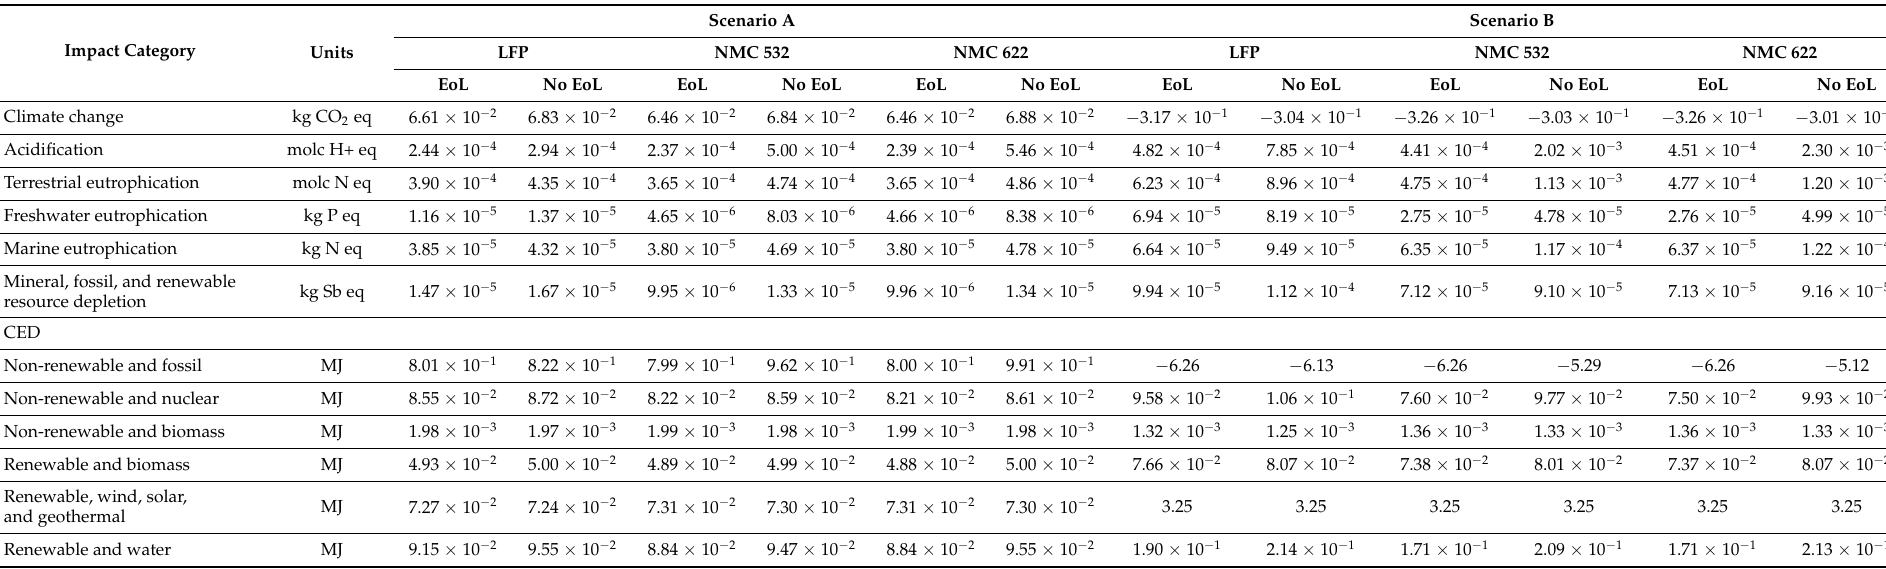
Table 9. Life cycle environmental impacts of storing and delivering 1 kWh of electrical energy in LFP, NMC 532, and NMC 622 stationary batteries. For the CED indicator, negative values indicate savings rather than energy consumption; for other impact categories, negative values indicate avoided